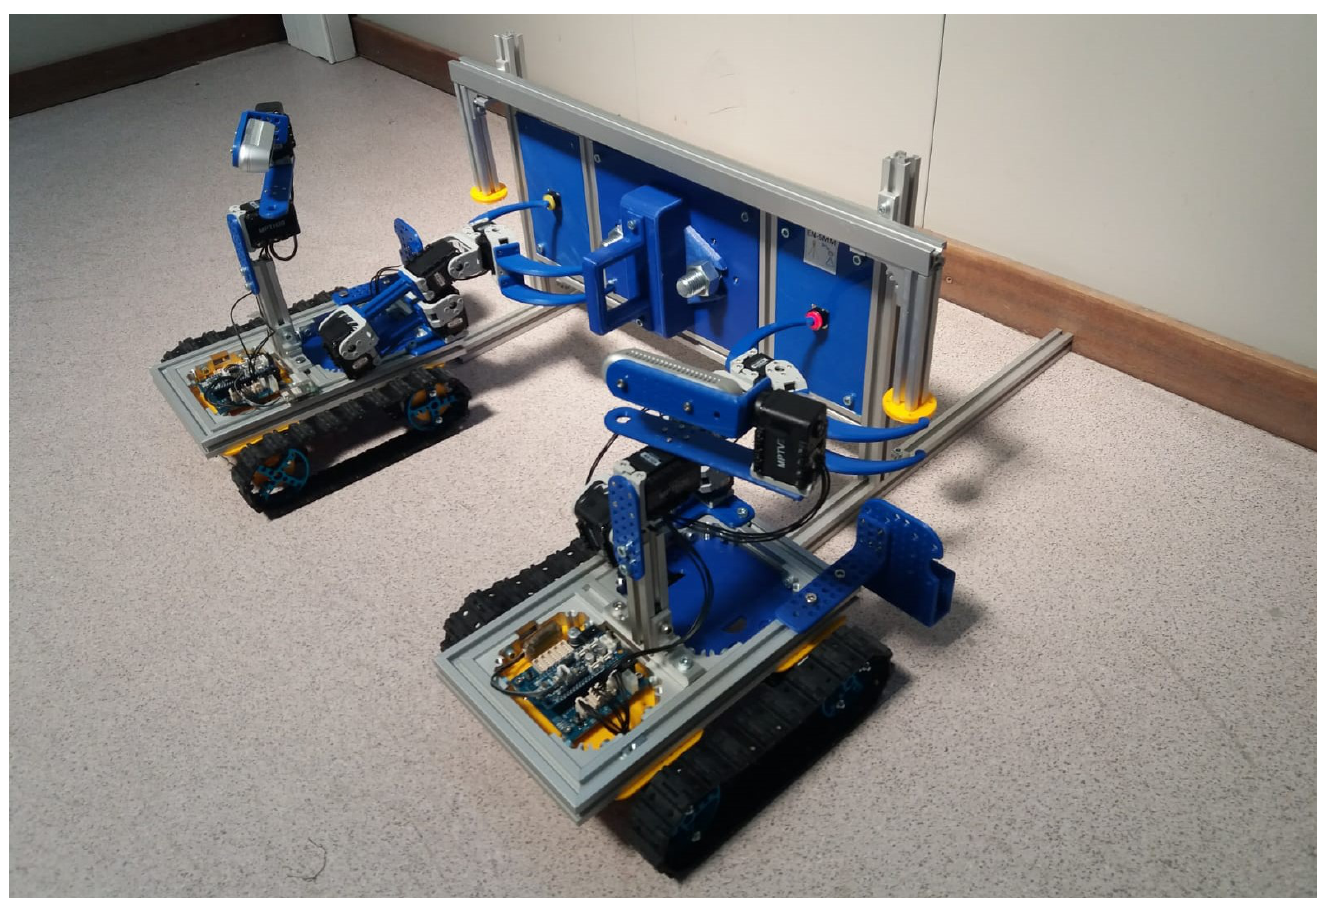
Figure 5. The MiniCernbot platforms and antimatter factory intervention panel